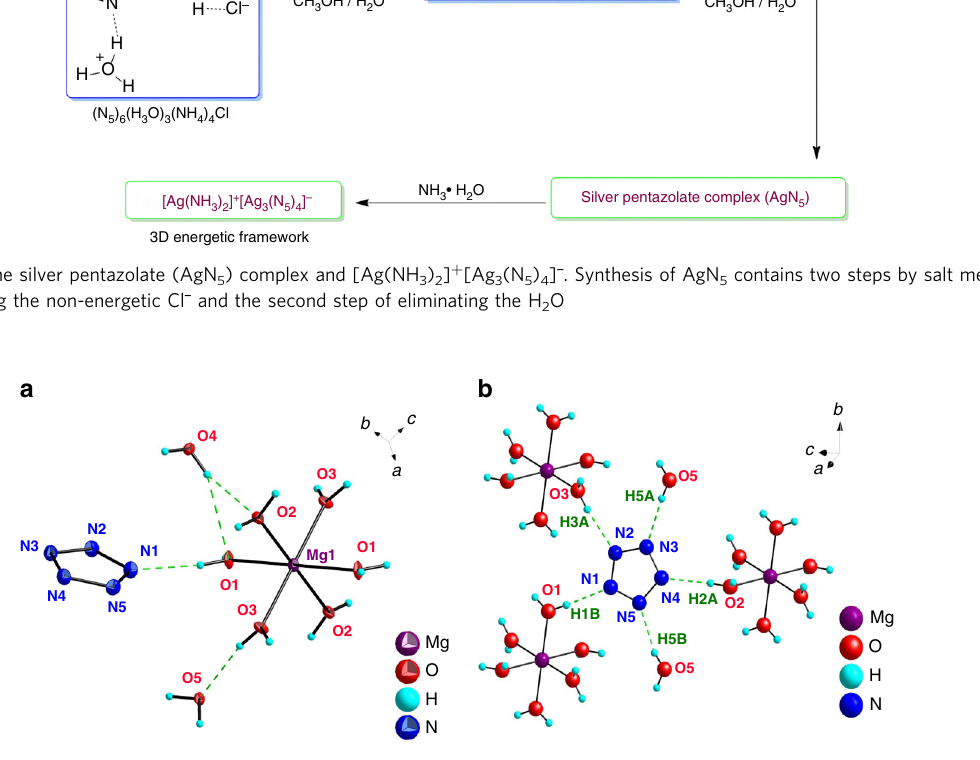
Fig. 2 Crystal Structure of [Mg(H 2 O) 6 ] 2 + [(N 5 ) 2 (H 2 O) 4 ] 2 ˉ . a ORTEP plot at the 50% probability level. b Coordination geometry of the cyclo -N 5 ˉ